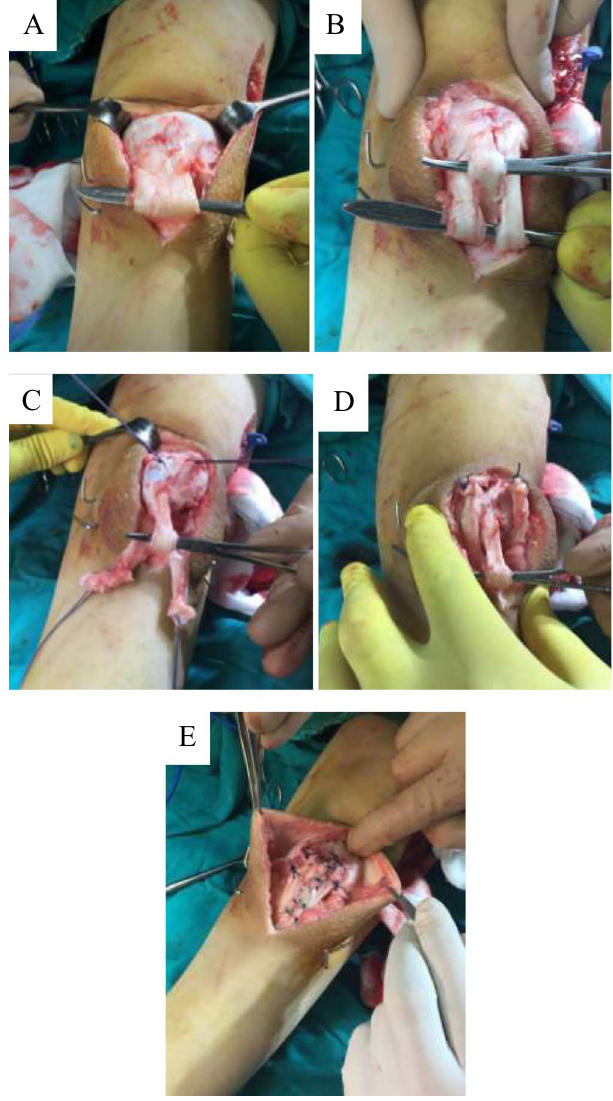
Figure 2. Surgical technique. (A) After midline incision the patellar tendon after dissection of the paratenon is shown. (B) Three equal slips are created by two vertical incisions taking care not to damage the distal insertion into the tibial tuberosity. (C) Stay sutures are applied to the two peripheral slips and by down pulling of the central slip the patella is brought into the desired position. (D) After radiological con fi rmation of the proper patellar position the stay sutures are tightened over the patella. (E) The central slip is double breasted, the three slips are joined together and augmentation by nonabsorbable suture material is done at the